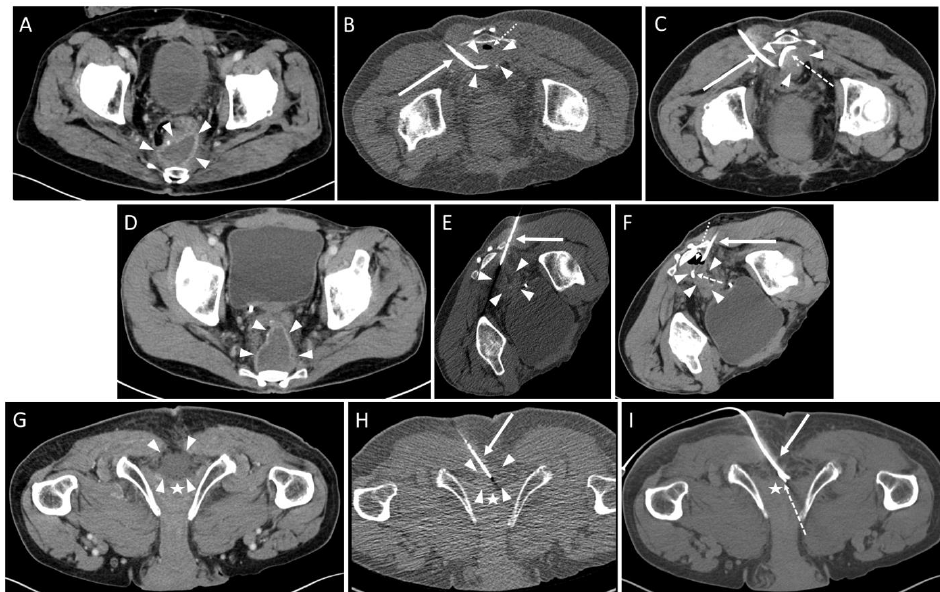
Figure 2. Three cases of pelvic fluid collections after colorectal cancer surgery. Three different access trajectories are depicted: Upper row: Transpiriform access path. of a 69 year-old male with a history of rectal carcinoma (T2 tumor stage) after deep anterior rectal resection including total mesorectal excision and the creation of a loop-iliostomy. Partial anastomotic insufficiency with concomitant presacral abscess was observed after two months and initially treated using endoluminal vacuum therapy. Subsequently, a CT fluoroscopy guided drain was inserted after four months (Leukocytes 8.3 × 10 9 /L; CRP: 1.6 mg/dL). ( A ) A preinterventional contrast enhanced CT shows a presacral fluid collection with marked rim enhancement (arrowheads). Loculated small gas collection indicating a fistula and superinfection. ( B ) CT fluoroscopy-guided insertion of a 10 F drain (arrow). Arrowheads: fluid collection; dotted arrow: loculated gas collection. ( C ) Postinterventional control scan. Reduced size of the fluid collection (arrowheads) after aspiration. Arrow: drain; dashed arrow: loop-formation of the distal drain segment. Microbiological analysis revealed infection with Enterococcus faecalis, Haemophilus parainfluenzae, Escherichia coli, Proteus vulgaris, Citrobacter koseri, and Bacteroides uniformis. Middle row: Infrapiriform access path. A 51 year-old male with history of hepatic metastatic rectal cancer (T3 tumor stage) and deep anterior rectal resection with Hartmann’s operation after neoadjuvant chemotherapy with FOLFOX4/FOLFIRI schema. Two months after surgery the patient presented with elevated temperature and fever spikes up to 39.5 degrees C (Leukocytes 17.4 × 10 9 /L; CRP: 5.4 mg/dL). A CT fluoroscopy-guided drain was applied. ( D ) A preinterventional contrast enhanced CT showed a presacral fluid collection with marked rim enhancement (arrowheads). ( E ) CT fluoroscopy placement of an 8 F drain (arrow) in semi-prone position. Arrowheads: fluid collection. ( F ) Postoperative control scan. After aspiration of the abscess cavity, a loculated small collection of air could be seen (dotted arrow). The size of the fluid collection (arrowheads) was reduced. A microbiological analysis revealed an infection with Bacteroides fragilis. Lower row: Transperineal access path. of a 74 year-old male with history of a deep-seated rectal carcinoma (yT3 tumor stage) after laparoscopic abdominoperineal rectum resection. The patient had fever of up to 39 degrees with recurrent spikes since the 9th postoperative day. Fifteen days after surgery, a CT revealed postoperative fluid retention in the pelvic floor extending to the penile root (Leukocytes 6.8 × 10 9 /L; CRP: 6.9 mg/dL). ( G ) A contrast enhanced planning CT scan in the prone position did not show rim enhancement or air bubbles within the collection (arrowheads). Asterisk: penile root. ( H ) CT fluoroscopy-guided insertion of an 8 F single lumen pigtail drain (arrow) into the perineal region using the Trocar-technique was performed. Arrowheads: fluid collection; asterisk: penile root. ( I ) Complete resolution of the fluid collection after aspiration was seen in the control scan. Arrow: drain; dashed arrow: loop-formation of the distal drain segment; asterisk: penile root. A microbiological analysis revealed infection with Proteus